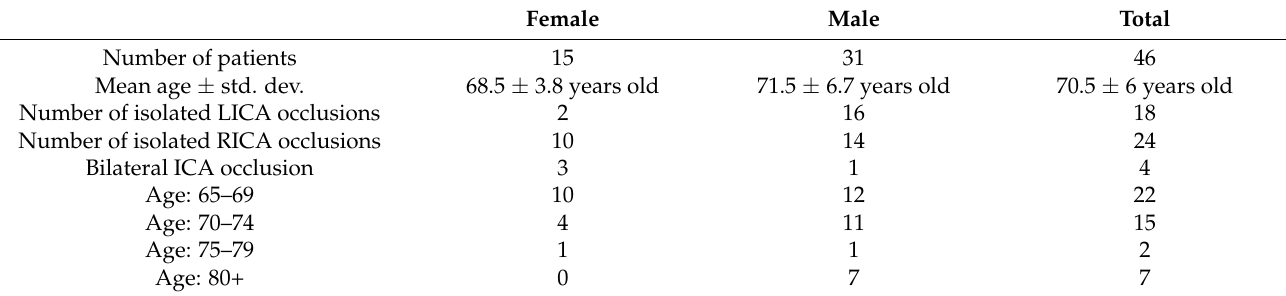
Table 1. Study group characteristics.